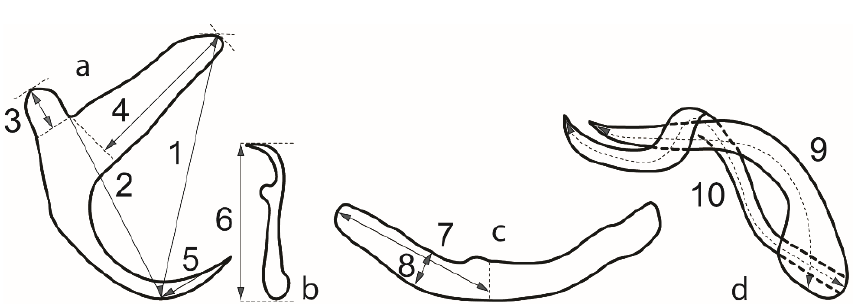
Figure 2. Measurements for hard parts of haptor and genitals of species of Kapentagyrus spp. (a) Anchor, 1-total length. 2-length to notch. 3-outer root length. 4-inner root length. 5-point length. (b) Hook, 6-length. (c) Bar, 7-branch length. 8-branch width. (d) Male copulatory organ, 9-copulatory tube axial length. 10-accessory piece axial length.